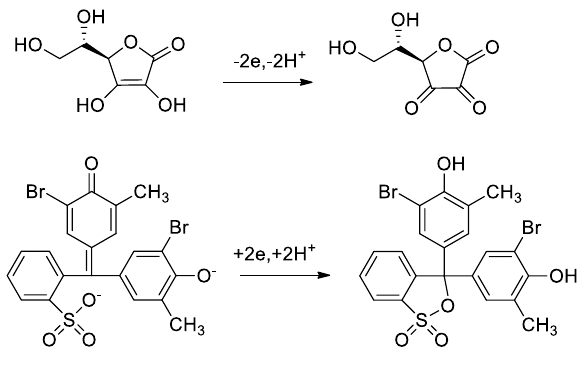
Fig. 1 Reaction between ascorbic acid and bromocresol purple